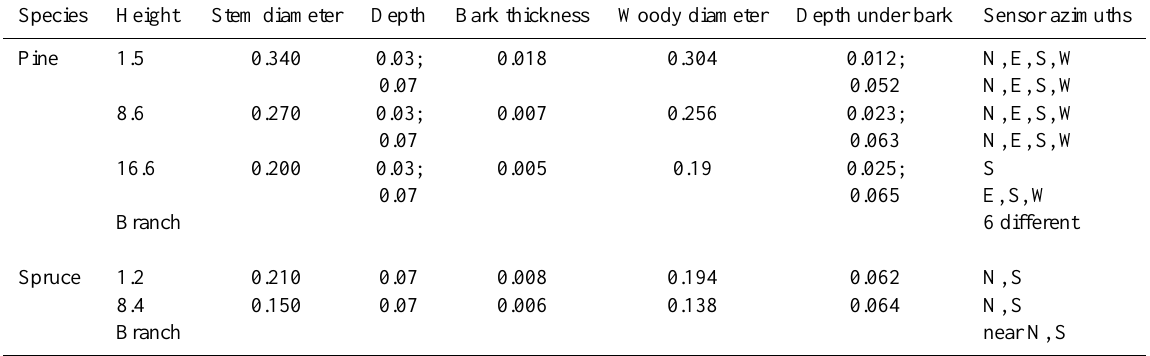
Table 1. Positioning of stem temperature sensors. All depth/height units in meters. Species Height Stem diameter Depth Pine